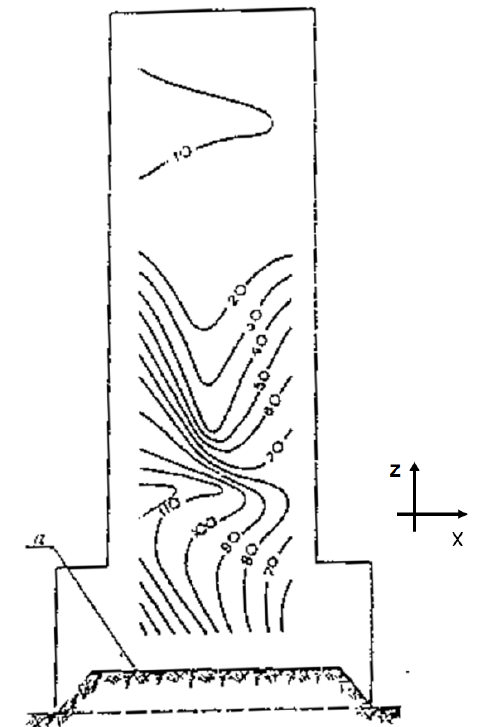
Fig. 2. Spatial distribution of the maximum pressure reached during the snow flow (in kPa) upon a flat surface of 8 × 3m 2 . Experimental measurements carried out by Kotlyakov et al. (1977) on real scale test